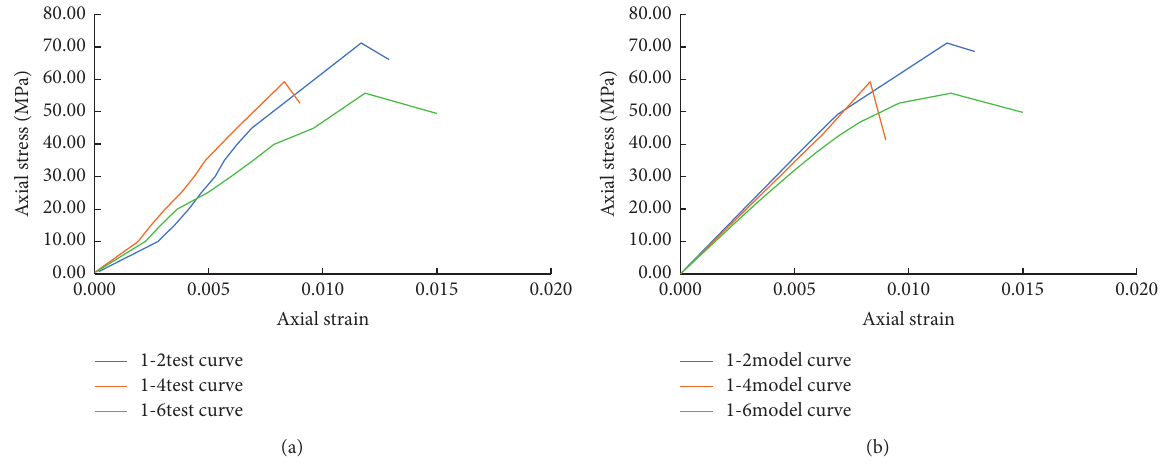
Figure 3: Stress-strain curve (II) of filled cracked rocks with gypsum mortar ( σ